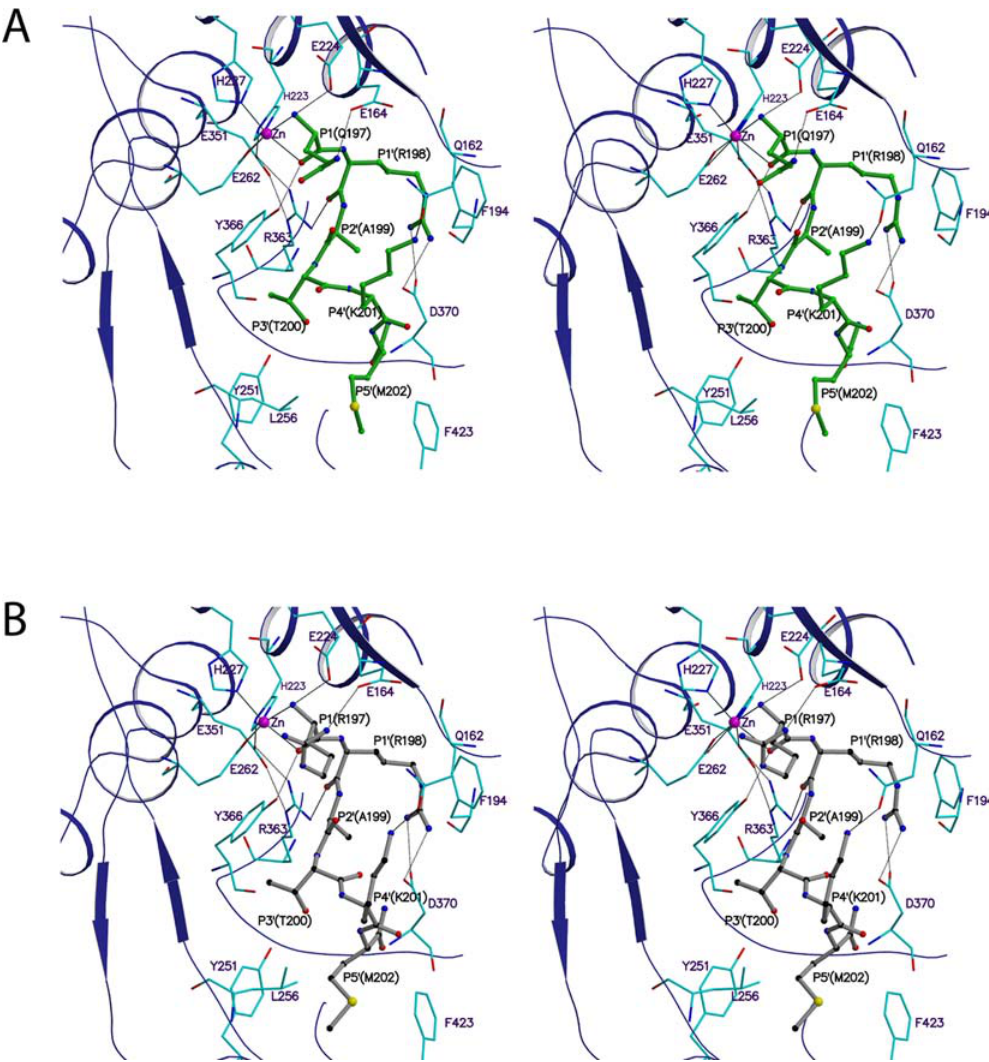
Figure 3. Structure of Balc424 in complex with the QRATKM, a segment of substrate SNAP-25. (A). Stereo view of the active site shows the molecular interactions between the substrate peptide (QRATKM) and protease (Balc424). Protease and substrate residues are shown in cyan and green, respectively. Blue color ribbon represents the protease secondary elements at the vicinity of the active site. (B). Stereo view of the active site center of Balc424 (cyan stick) with RRATKM (gray ball and stick). Oxygen, nitrogen, sulfur and zinc atoms are shown in red, blue, yellow and magenta, respectively. Hydrogen bonds are depicted as black dash lines while zinc co-ordination is shown in solid line.